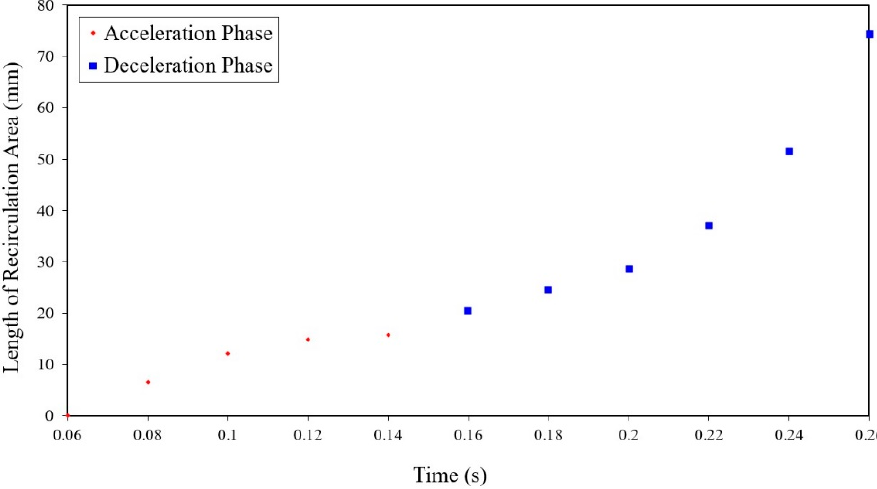
Figure 10. Length of the recirculation area during the acceleration and deceleration phase of the cardiac cycle.